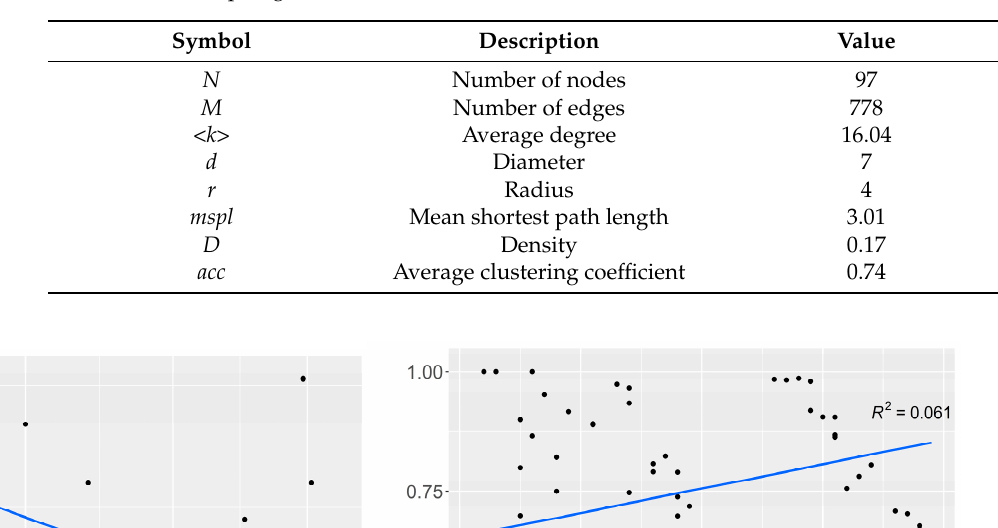
Table 1. Global Topological Parameters of the IPIN.